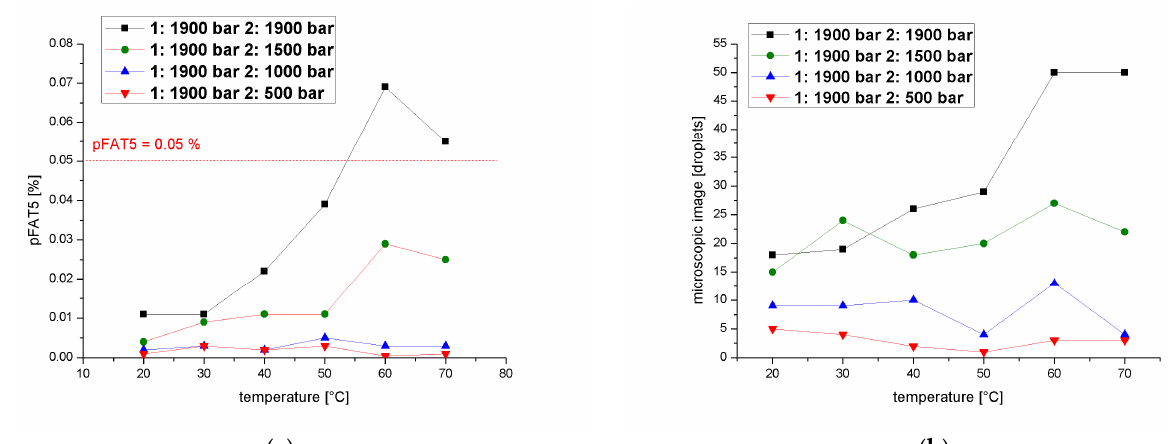
Figure 9. Effect of a two-cycle process (first cycle =1900 bar) on the pFAT5 value and droplet counts. ( a ) The pFAT5 value of the second homogenization cycle as a function of temperature at different operating pressures (500–1900 bar). ( b ) The droplet count of the second homogenization cycle as a function of temperature at different operating pressures (500–1900 bar).